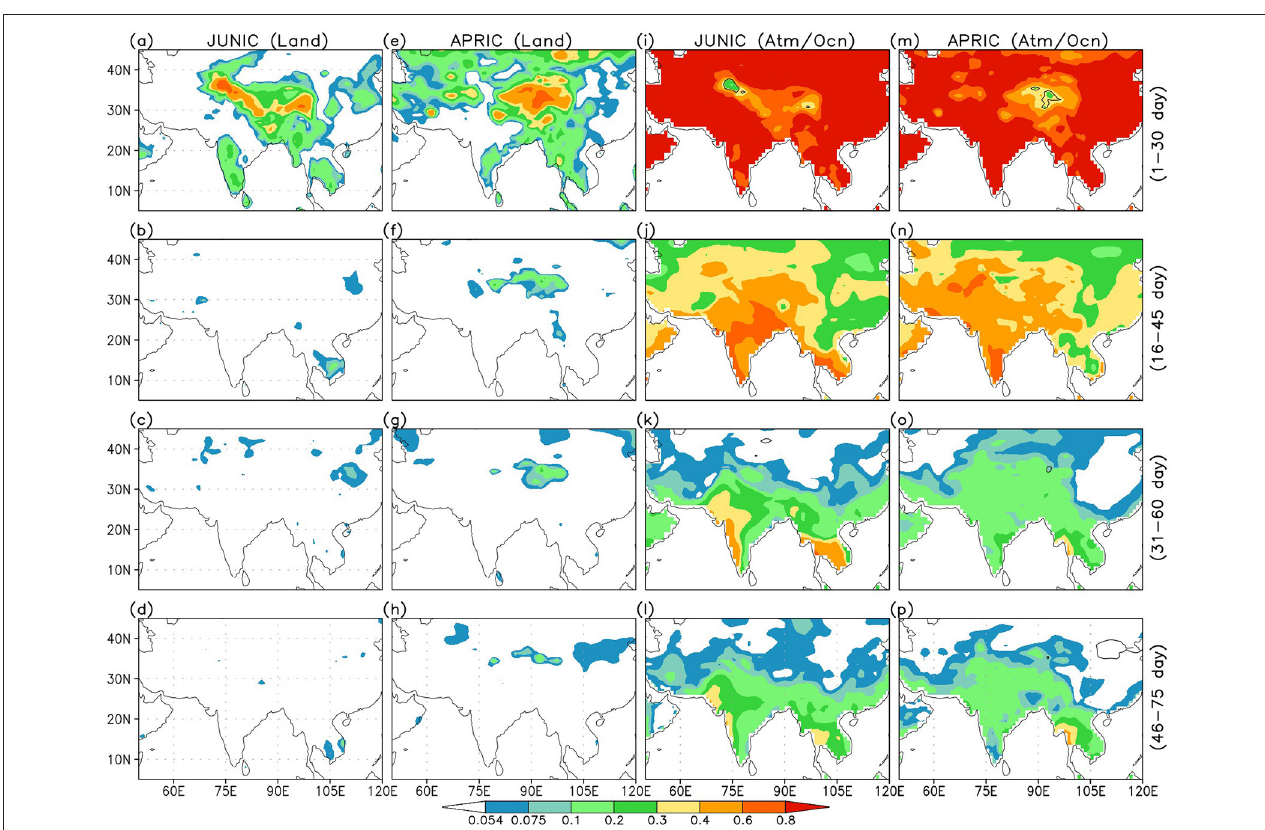
FIGURE 10 | Potential predictability of 2m air temperature in CFSv2 JUNIC hindcasts due to land initial conditions, expressed as a signal-to-total variance ratio and based on (a) 1–30 day, (b) 16–45 day, (c) 31–60 day and (d) 46–75 day averages. (e–h) respectively, show the same for APRIC hindcasts. (i–p) depict the potential predictability due to ocean initial conditions in JUNIC and APRIC hindcasts. All shaded areas are significant at the 95% confidence level. Black contours depict the areas where the variance ratios of signals due to land vs. ocean ICs are